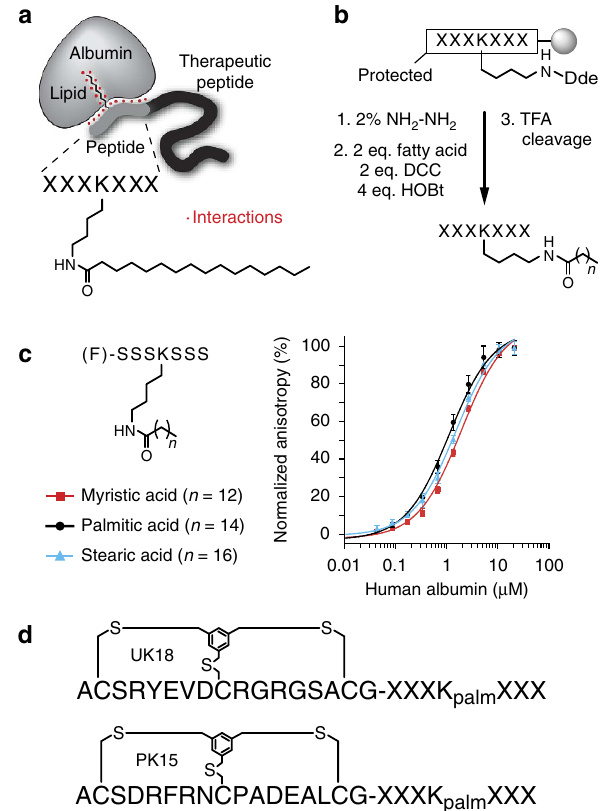
Figure 1 | Albumin-binding ligand based on a chimeric peptide-fatty acid structure. ( a ) Peptide-fatty acid tag is appended to either end of a therapeutic peptide. Amino acids X strengthen the binding of the fatty acid that is linked via its carboxylic group to the side chain of a lysine. ( b ) Synthesis of peptide-fatty acid tag on solid phase. ( c ) Binding of chimeric peptide-fatty acid structures to albumin measured by fluorescence polarization. The peptide is modified at the N-terminus with fluorescein (F). Average values and s.d.’s of three measurements are shown. ( d ) Bioactive bicyclic peptides tagged with palmitoylated peptide. palm ¼ palmitoyl, X ¼ Gly or